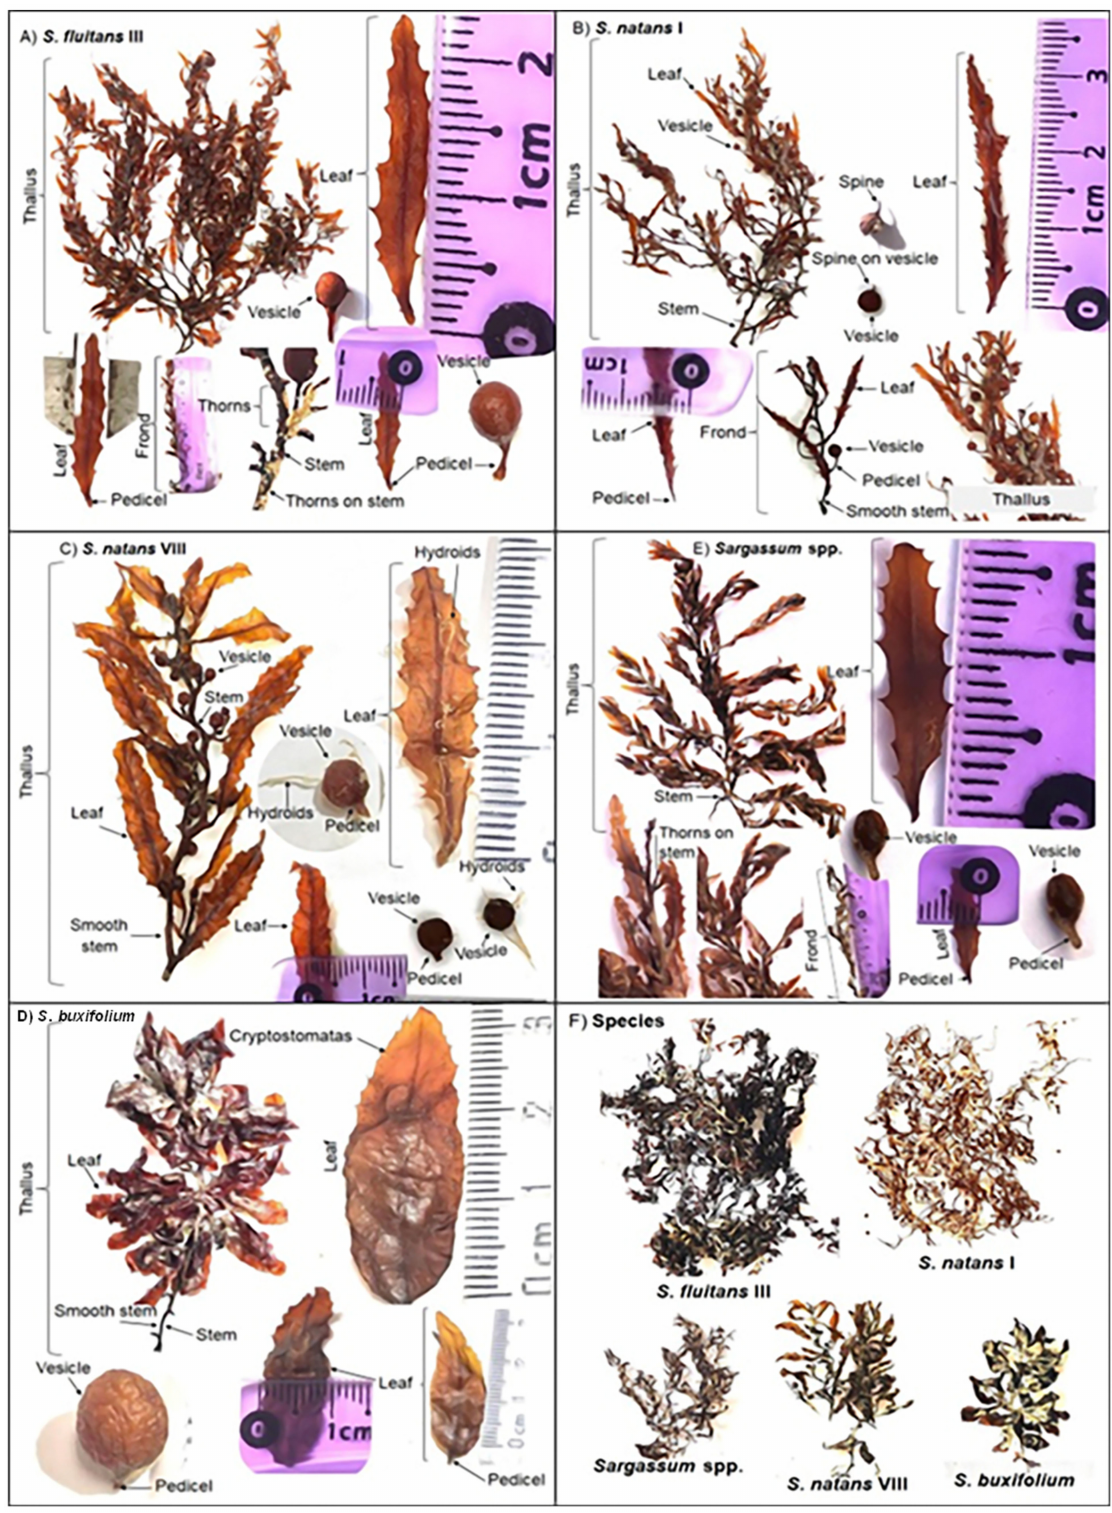
Figure 1. In the image you can see the different species of Sargassum that were identified. ( A ) Sar- gassum fluitans III representative morphological characteristics of the species (thallus with spines). ( B ) Sargassum natans I with vesicles with projections of phyllodes or with spine. ( C ) Sargassum natans VIII hydroids attached to the cauloid; vesicles and phyllodes can be observed. ( D ) Sargassum buxifolium benthic species. ( E ) Sargassum spp., unidentified species, and ( F ) dehydrated